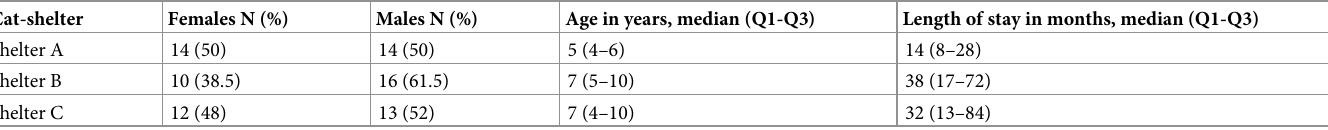
Table 1. Gender distribution, age and length of stay of the 79 cats in the three shelters. Cat-shelter Females N (%) Shelter A Shelter B Shelter